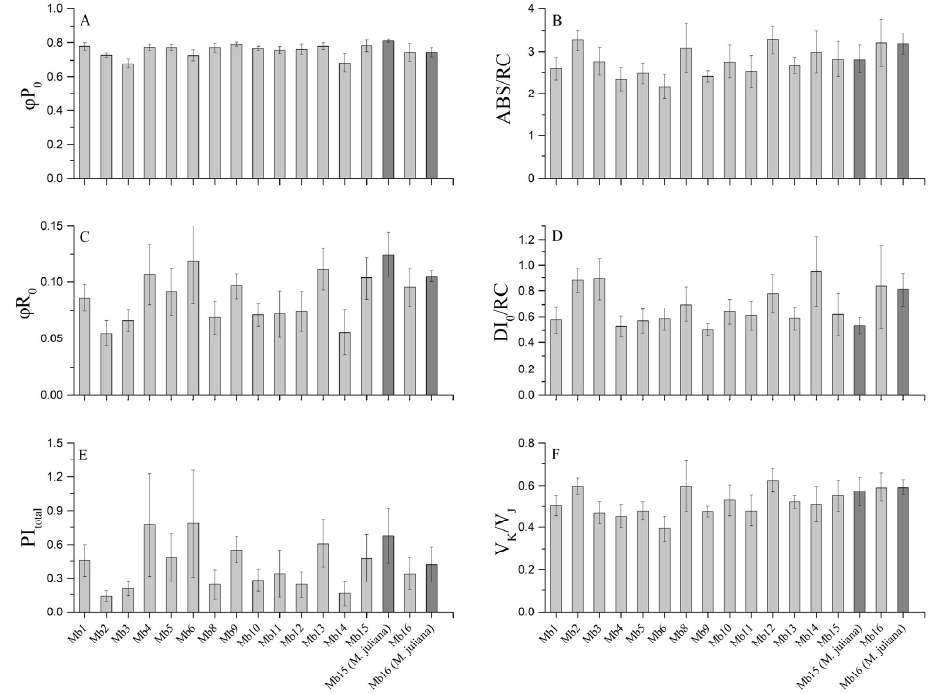
Figure 3. Chlorophyll fluorescence parameters for the different subpopulations of M. browiczii (light grey columns) and of M. juliana (dark grey columns). Mean values ± SD, ( n = 10–15). ( A ): Maximum quantum yield of primary PSII photochemistry ( ϕ P 0 , A); ( B ): absorbed photon flux per active reaction center (ABS/RC); ( C ): quantum yield for reduction in end electron acceptors at the PSI acceptor side ( ϕ R 0 ); ( D ): dissipated energy flux per active reaction centre (DI 0 /RC); ( E ): potential for energy conservation from exciton to the reduction in PSI end acceptors (PI total ) and ( F ): measure of the relative amplitude of K band (V K /V J ) (related to oxygen evolving complex